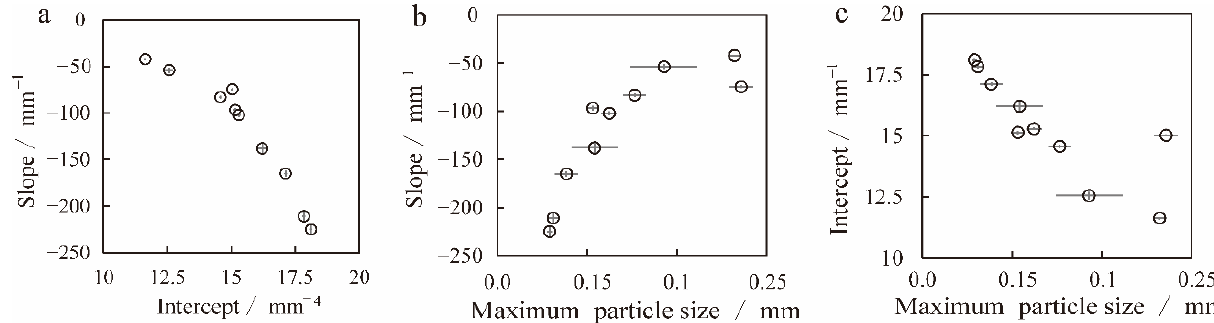
Figure 8. Covariant relation among CSD variables and dynamical significance. ( a ): The relationship between the slope and intercept of the CSD regression line. ( b ): The relationship between slope and maximum particle size. ( c ): Relationship between intercept and maximum particle size.